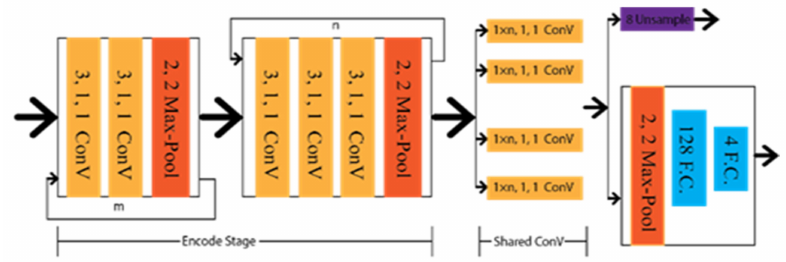
Figure 10. Schematic diagram of